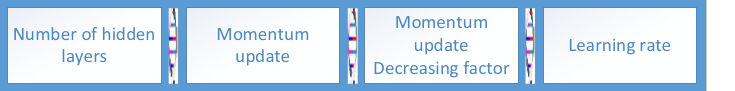
Figure 8. Sample GA-ANN Chromosome.